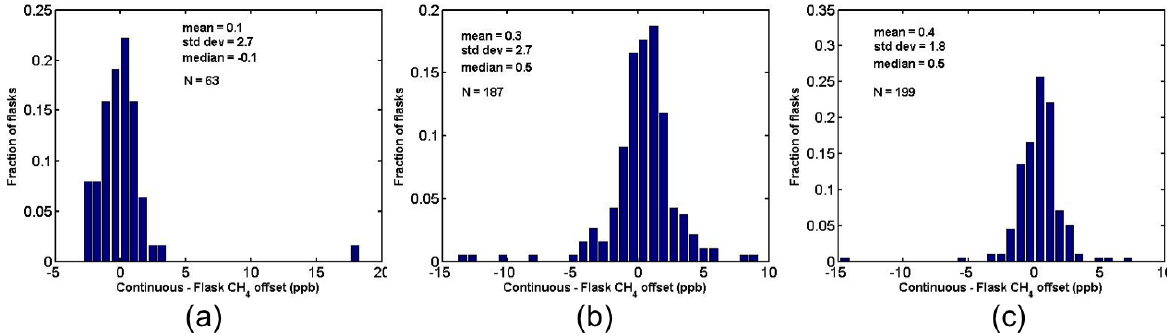
Fig. 10. Differences between continuous (CRDS) CH 4 measurements and flask CH4 measurements during flights over Alaska on the USCG C-130 for three seasons: (a) 2009, (b) 2010, and (c) 2011. The mean for each season, 1- σ standard deviation, and number of flasks for comparison are indicated on each